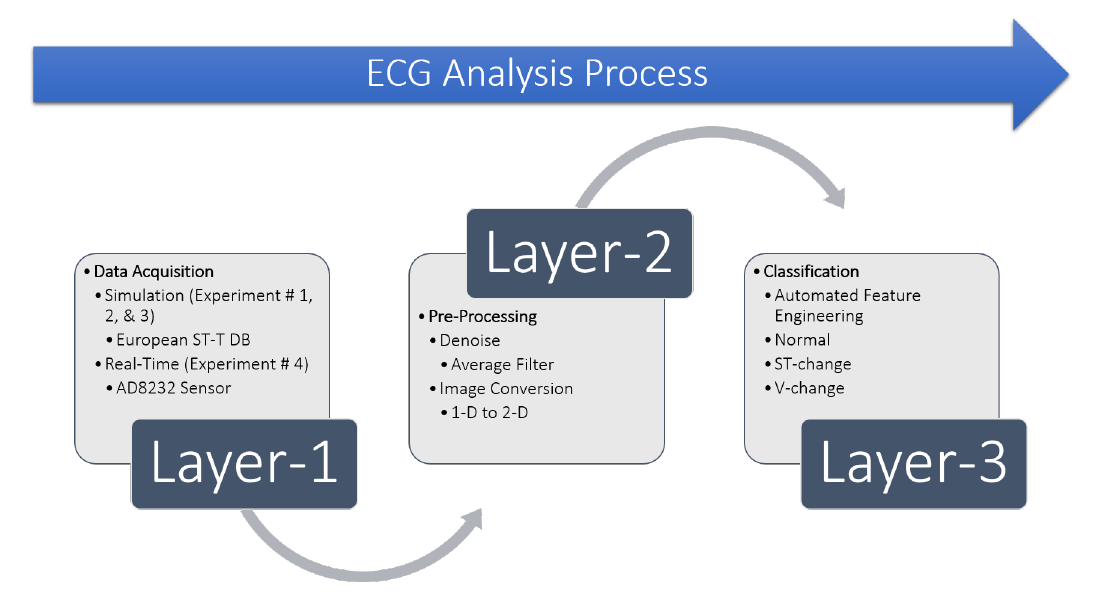
Figure 3. Layer-based ECG Analysis